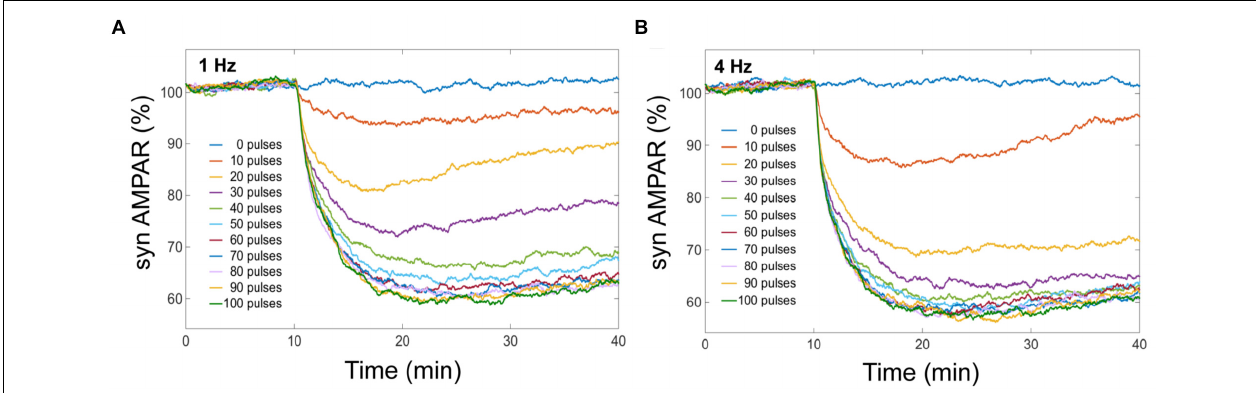
FIGURE 4 | LTD is selectively induced by specific number of Ca 2 + pulses. Mean of number of AMPA receptors when depression is induced by different number of Ca 2 + pulses at different frequencies. Successful LTD is obtained when the mean of AMPA receptors decreased to less than 70%. (A) At 1 Hz the minimum number of calcium pulses to observe LTD is 50, and (B) LTD is induced by 30 pulses at 4 Hz.